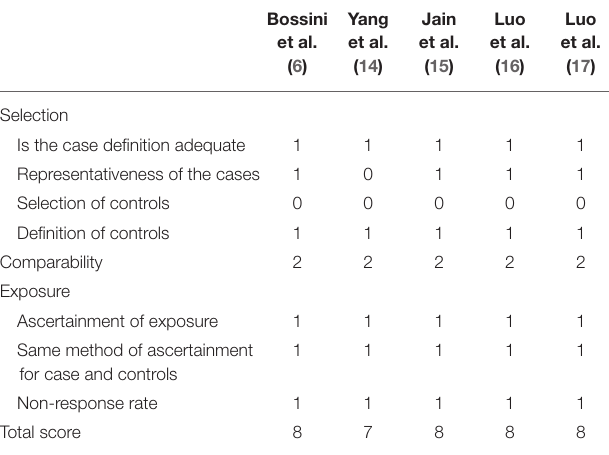
TABLE 2 | Quality assessment of each included